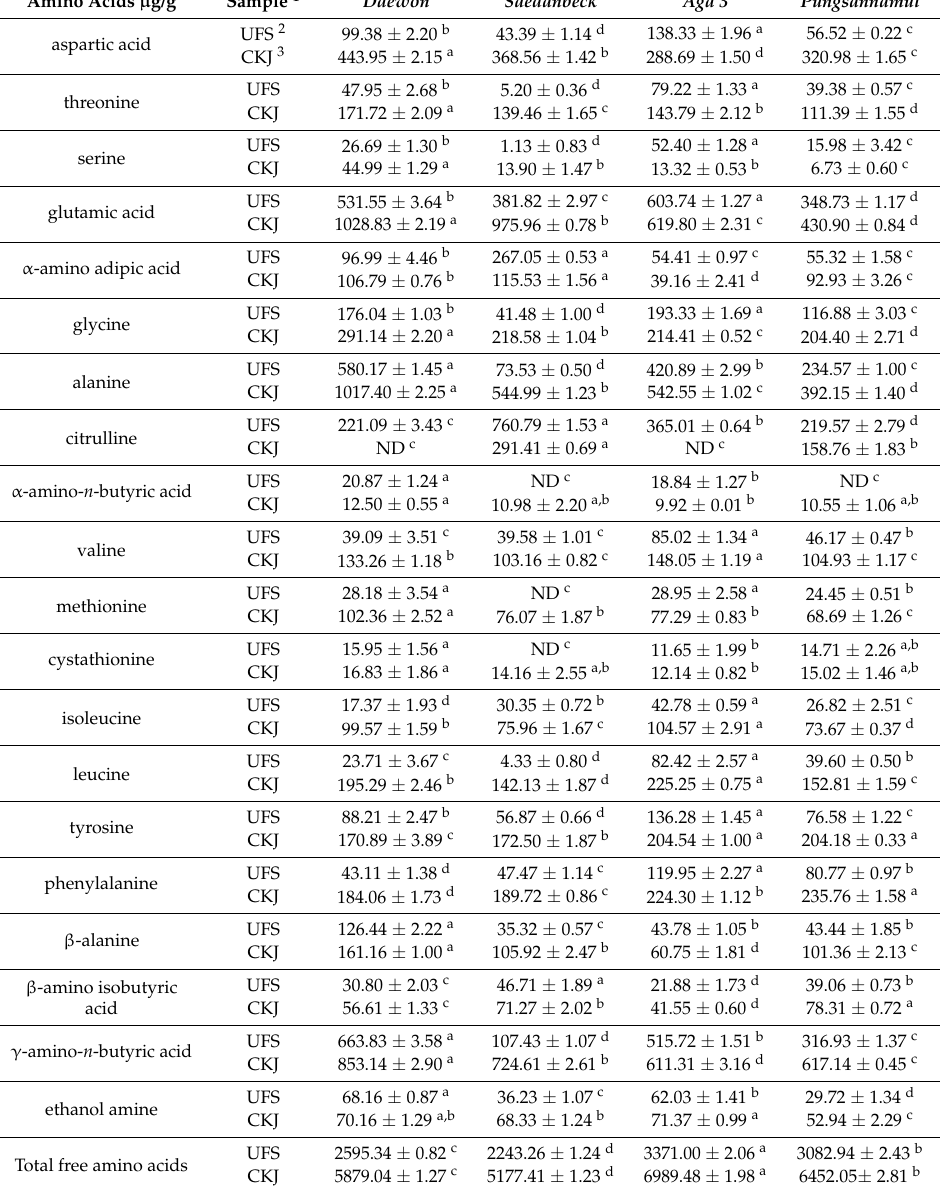
Table 3. Analysis of free amino acid composition in unfermented soybean and cheonggukjang fermented by Bacillus subtilis (KCTC 13241) in different soybean cultivars. Amino Acids µ